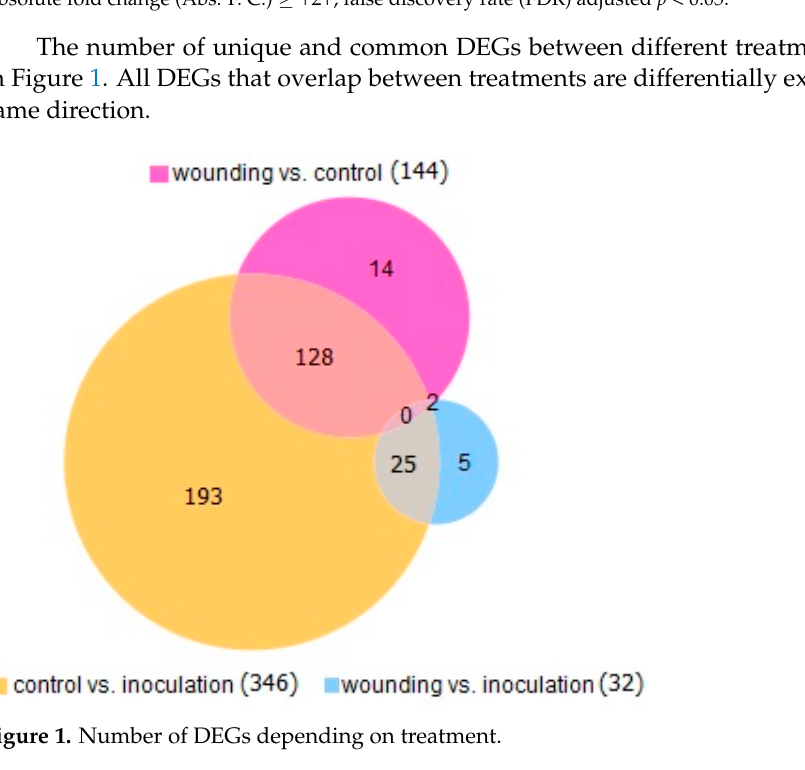
Table 2. Number of significantly up- or downregulated transcripts depending on treatment. Number of Upregulated Number of Downregulated Compared Transcripts Transcripts Inoculated vs. control 230 116 Wounded vs. control 96 48 Inoculated vs. wounded 30 2